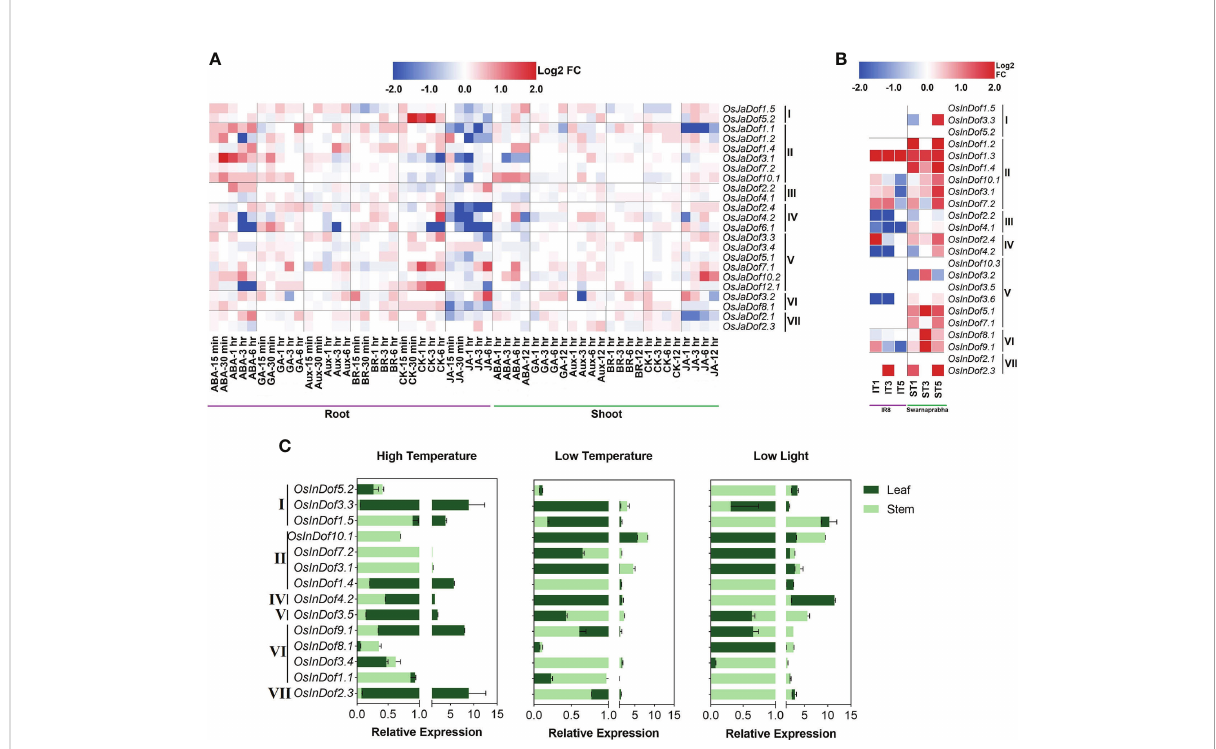
FIGURE 6 Expression pro fi les of Dof genes under stressful conditions. (A) RNA-seq-based normalized (Log 2 fold change) expression patterns of O. sativa japonica Dof genes in phytohormones treated roots and shoots. Hormone treatments are listed in columns and Dof genes in rows. Roman numbers on the left of the gene names indicate different Dof sub-groups. Abbreviations; ABA (abscisic acid), GA (gibberellic acid), Aux (auxin), BR (brassinosteroid), CK (cytokinin), JA (jasmonic acid). (B) RNA-seq-based normalized (Log 2 fold change) expression patterns of O. sativa indica Dof genes in response to low light treatments in susceptible (IR8) and tolerant (Swarnaprabha) rice genotypes. Abbreviations: IT1 (IR8 treated with low light for one day), IT3 (IR8 treated with low light for three days), IT5 (IR8 treated with low light for fi ve days), ST1 (Swarnaprabha treated with low light for one day), ST3 (Swarnaprabha treated with low light for three days) and ST5 (Swarnaprabha treated with low light for fi ve days). (C) Relative expression pro fi les of O. sativa indica Dof genes after one week of high temperature (40 ± 1°C), low temperature (15 ± 1°C), and low light (20% of control; 60 µmolm -2 s -1 ) treatments during 14h daylight periods in 93-11 indica rice